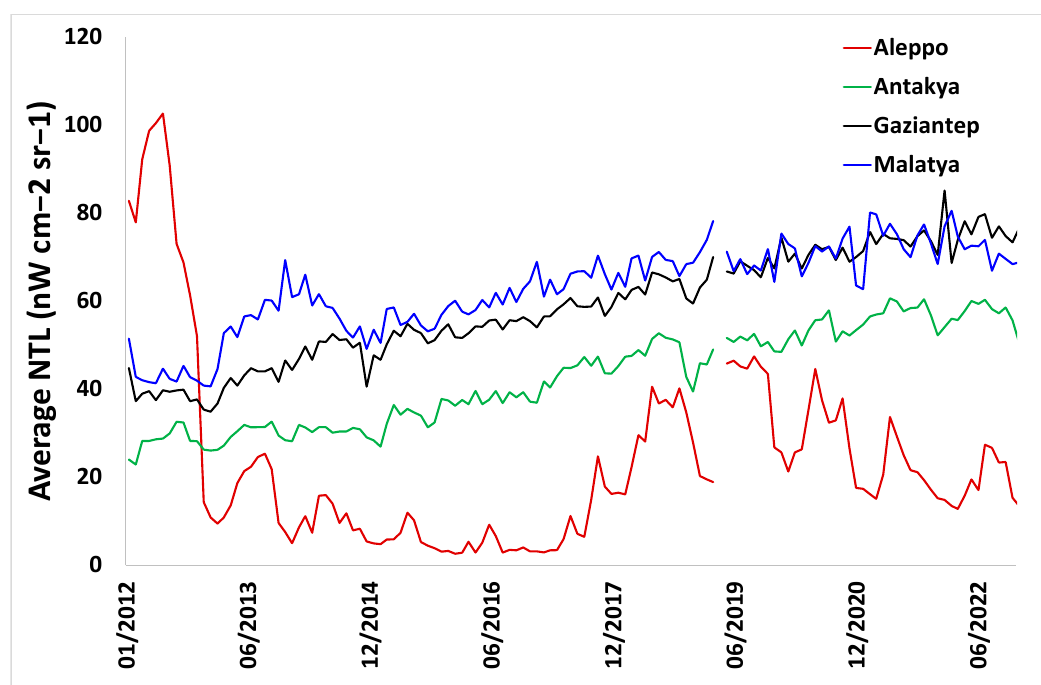
Figure 11. Average monthly nighttime lights (derived from BRDF corrected VIIRS monthly data) for the city centers of Aleppo, Syria and three cities in Turkey: Antakya (Hatay Merkez), Gaziantep and Malatya.